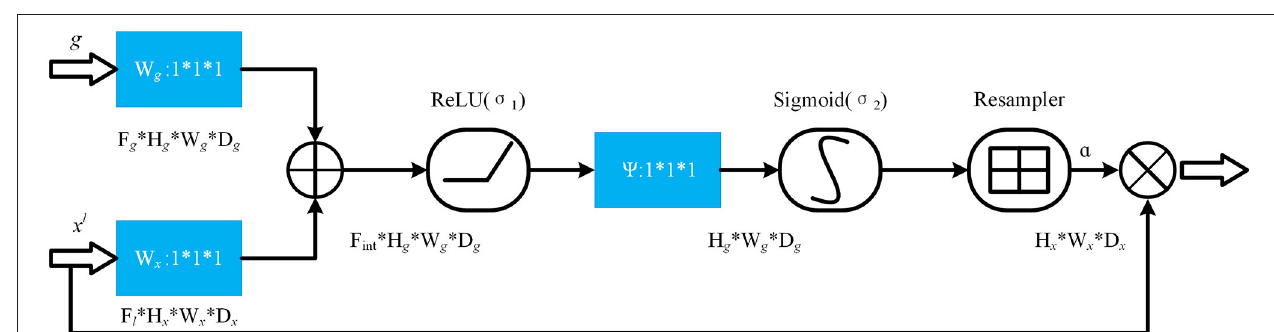
FIGURE 5 | The structure of attention